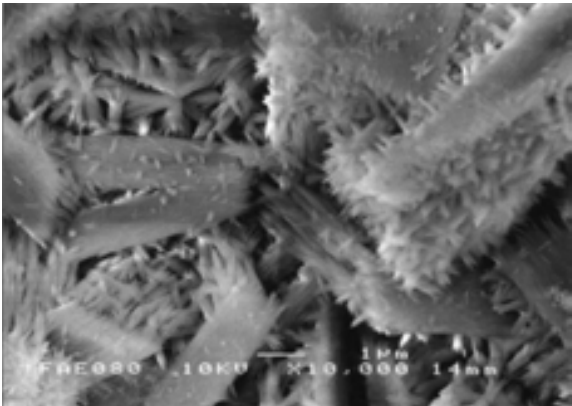
Figure 3. Cross section the specimen electrolytically coated with hy- droxyapatite (x